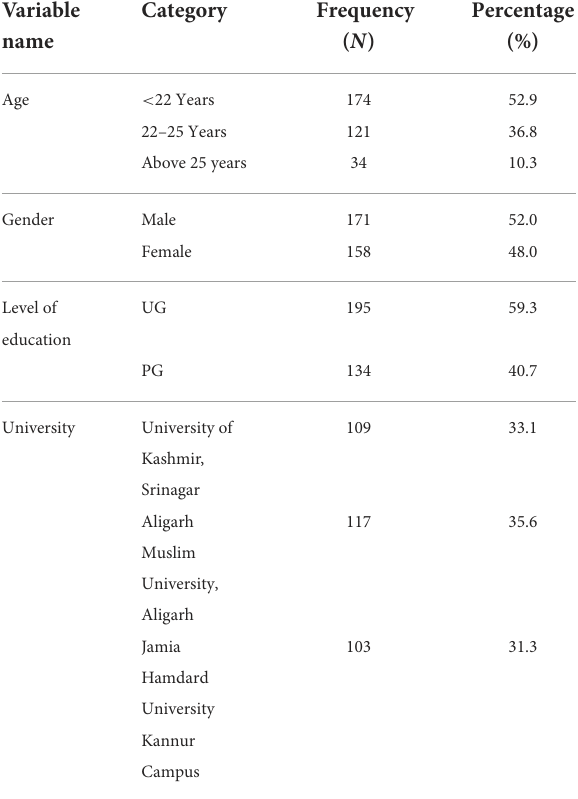
TABLE 1 Demographic profile of the sample ( N = 329).